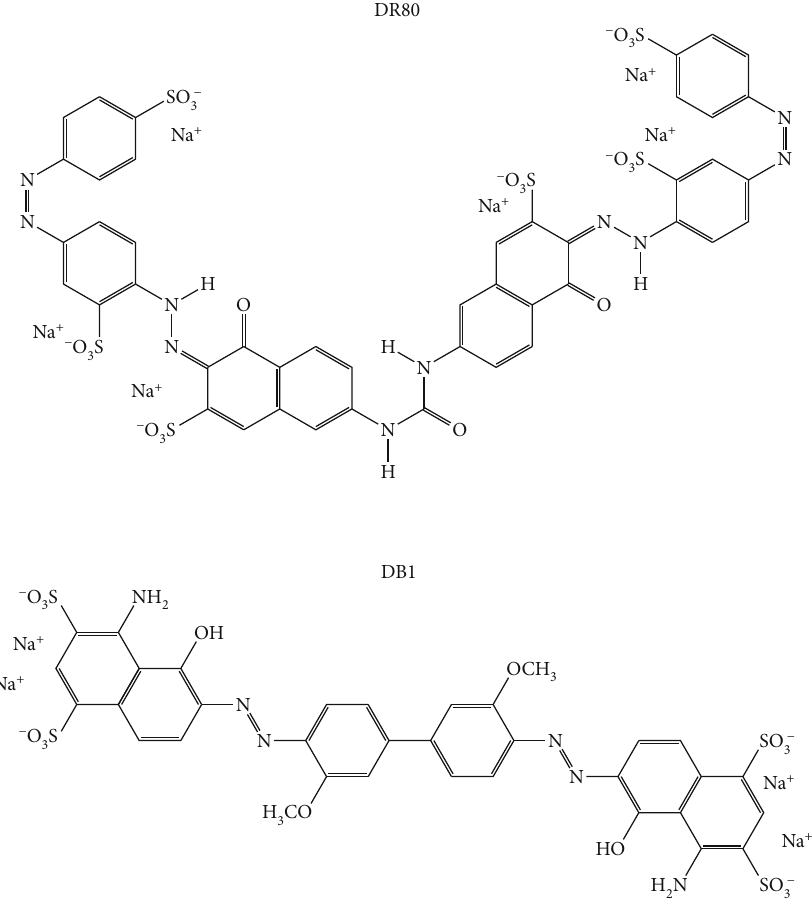
Figure 2: Chemical structures of the dyes used in this